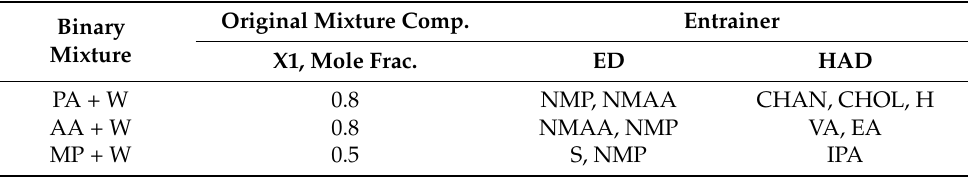
Table 1. The compositions of original mixtures and entrainers for ED and HAD.